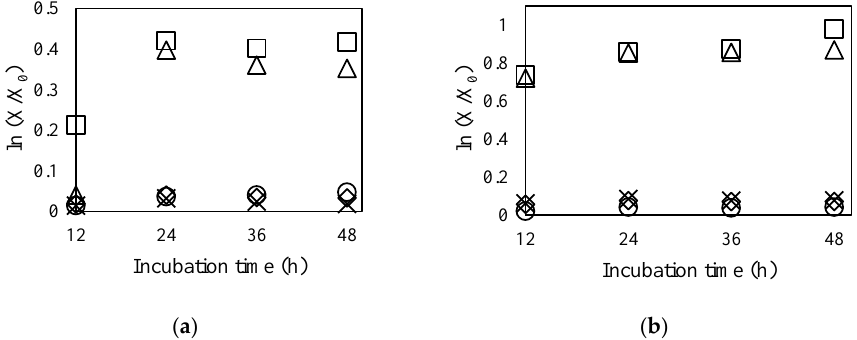
Figure 4. Growth curves of B. bifidum BGN4 ( a ) and B. longum BORI ( b ) in modified MRS with various carbon sources: basal medium (glucose-free MRS, ◇ ), basal medium with 0.5% mucin (×), 1.0% mucin ( ⚪ ), 0.5% glucose ( Δ ), and 1.0% glucose ( □ ).